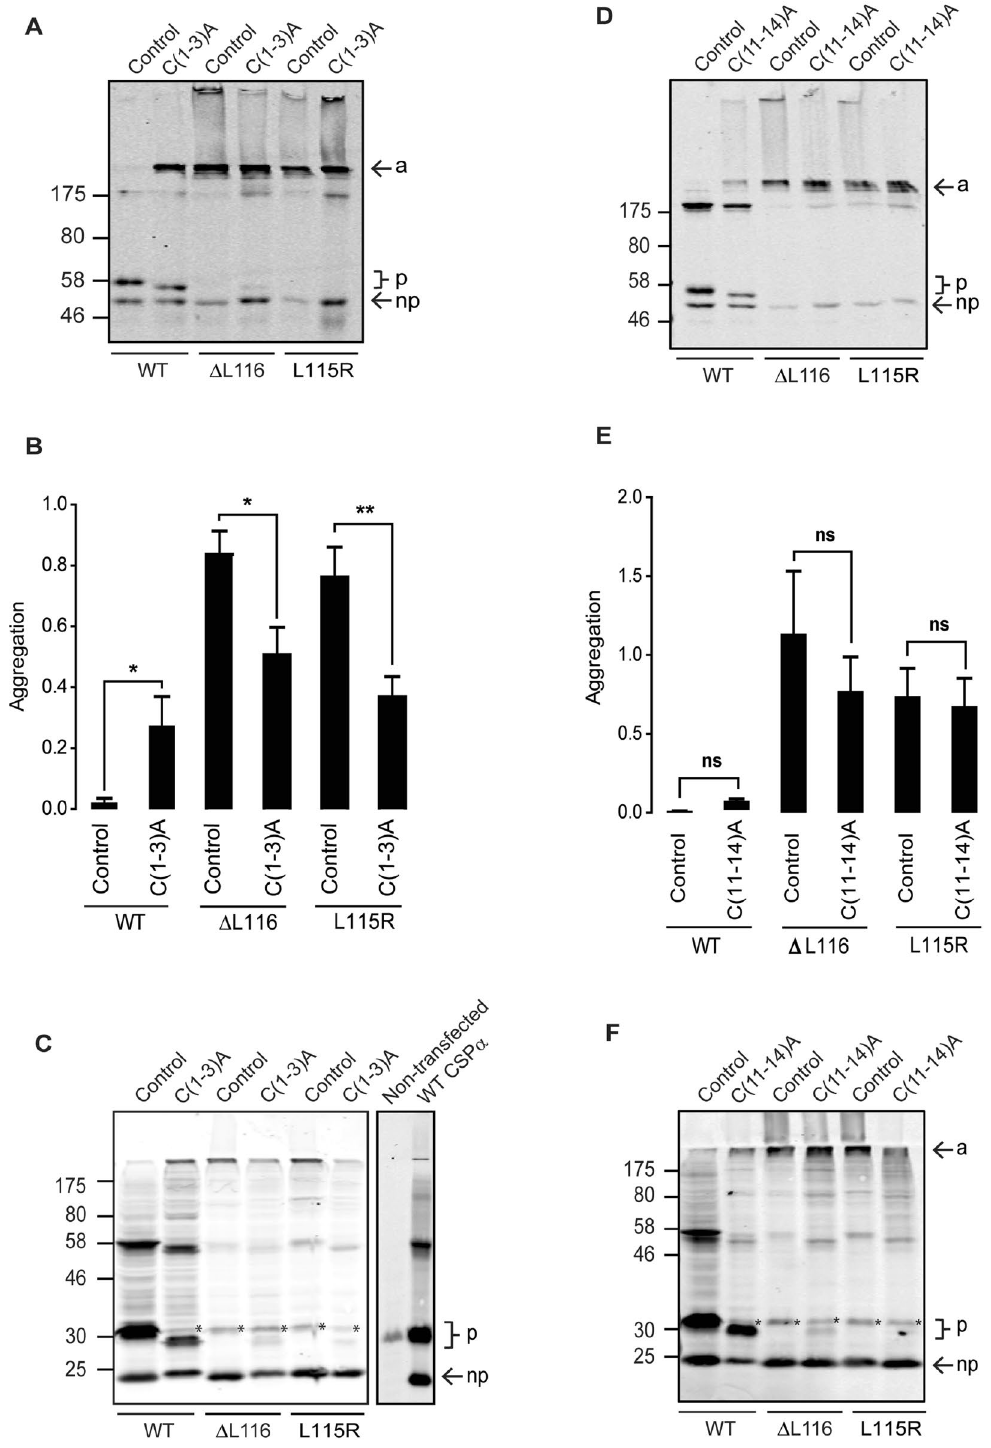
Figure 2. Effect of C(1-3)A and C(11-14)A substitutions on aggregation of CSP α ANCL mutants. PC12 cells were transfected for 48 hours with EGFP-tagged or untagged CSP α constructs. Cell lysates were resolved by SDS- PAGE and analysed by immunoblotting with anti-GFP antibody ( A and D ) and anti-CSP α antibody ( C and F ). a indicates aggregates, p shows position of palmitoylated monomeric CSP α , and np designates the non-palmitoylated monomers. Position of size markers are shown on the left hand side. Asterisks in panels C and F indicate endogenous palmitoylated CSP α . In panel C, the immunoblot on the right provides a comparison of CSP α expression levels in untransfected and transfected cells. Quantification of EGFP-CSP α proteins is presented as a ratio of aggregated to monomeric + dimeric forms of the proteins (n = 4), shown together with SEM (error bars) (panels B and E). The data was analysed using an unpaired Student’s T test; asterisks denote a significant difference ( * p < 0.05 , ** p < 0.01 ) from the respective control CSP α construct (wild-type, Δ L116 or